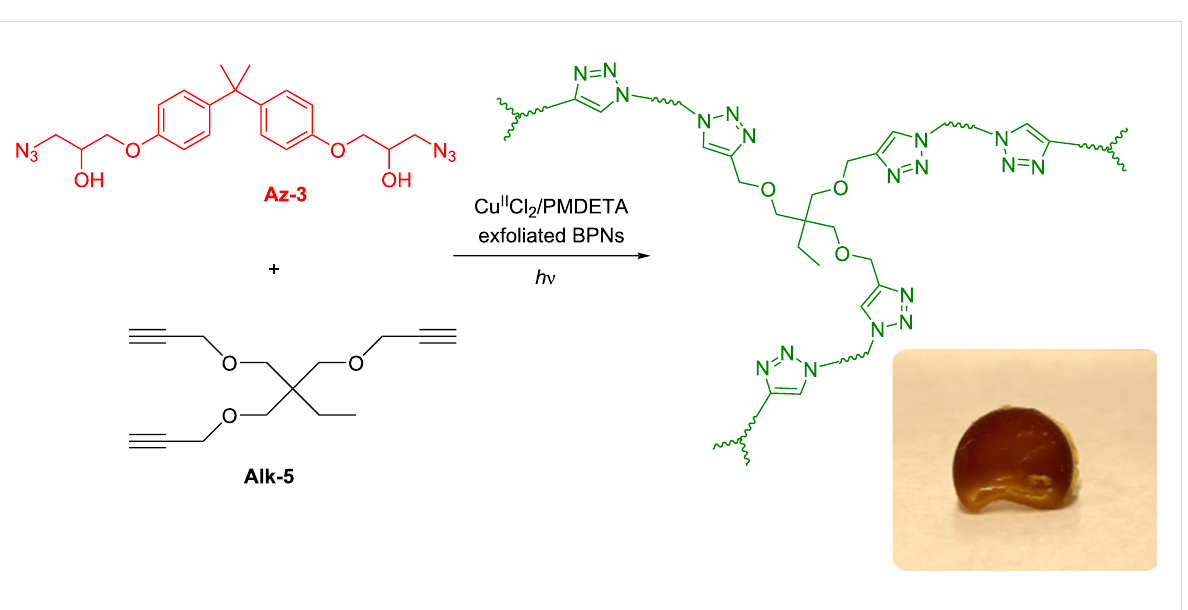
process leads to the formation of BPNs-embedded cross-linked polymers. The darker regions circled with yellow dashed line